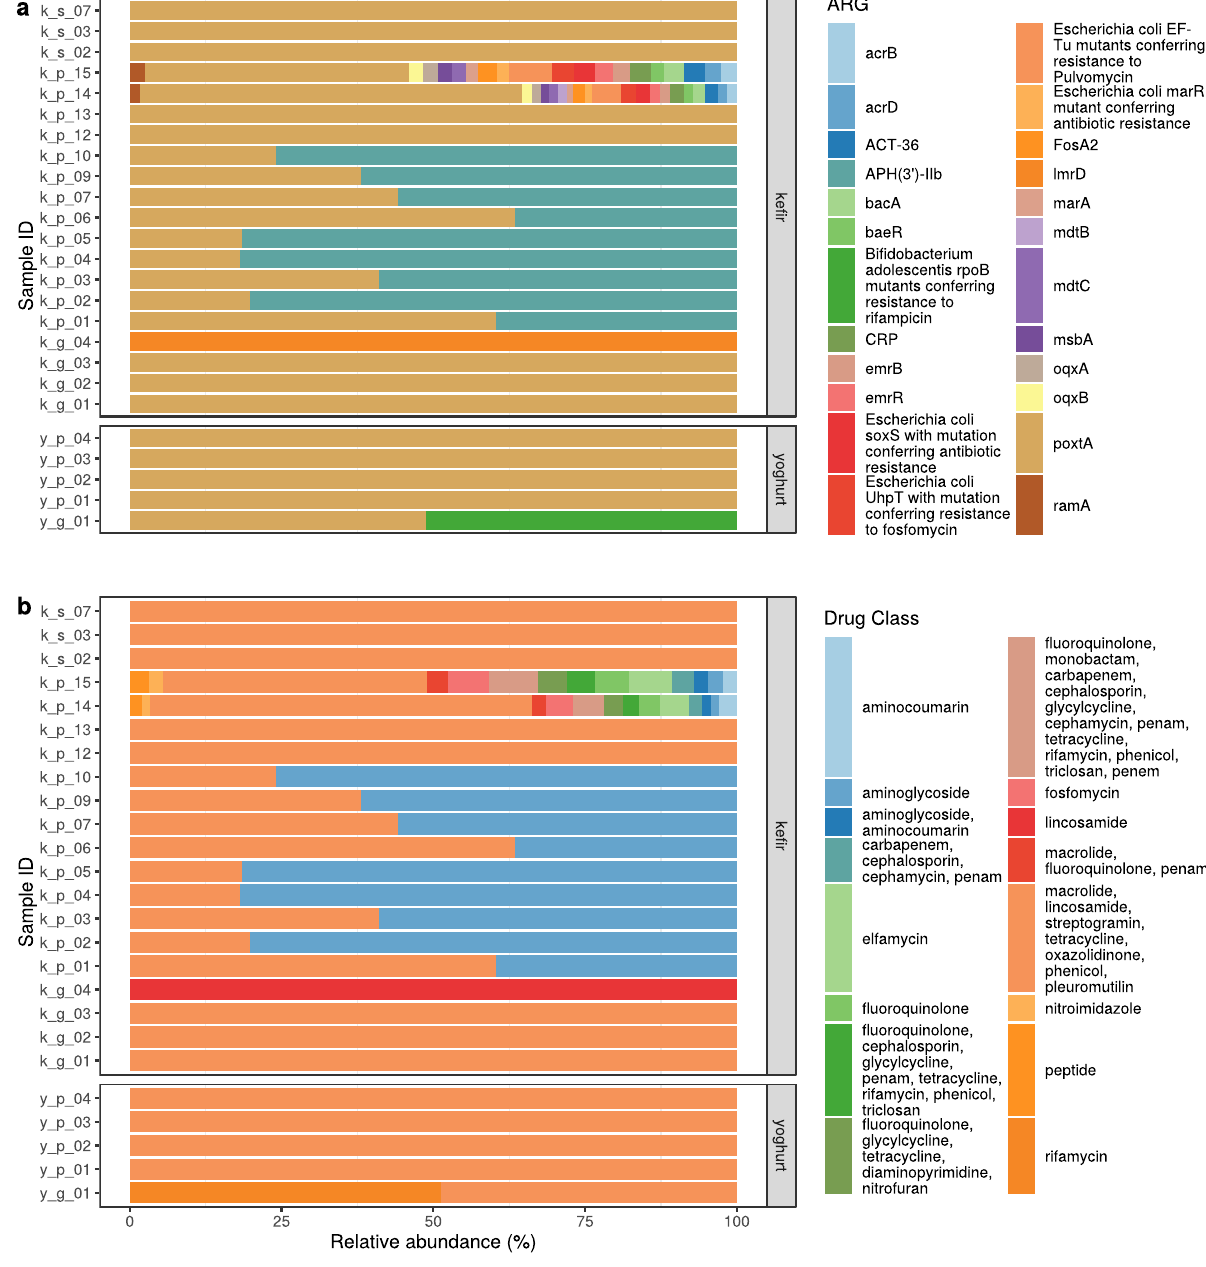
Figure 3. Antimicrobial resistance (AMR) abundance in kefir and yoghurt samples. ( a ) Relative abundance of AMR genes. ORFs having at least 60% length and 90% base sequence identity with the reference ARG sequence are shown. Some samples (k_s_01, k_s_04, k_s_05, k_s_06, k_p_08) are not shown as their ORFs did not meet filtering criteria. ( b ) Relative abundance of drug classes related to the ARGs identified in the